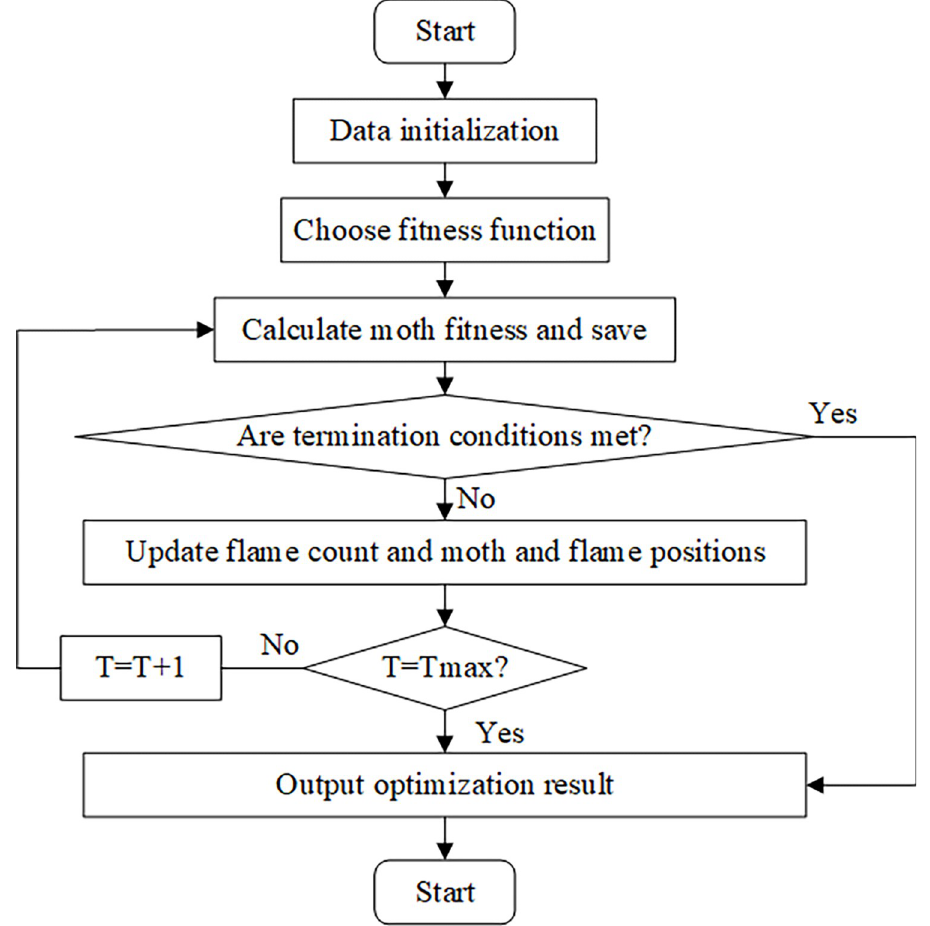
Fig 12. Model optimization flow by MFO